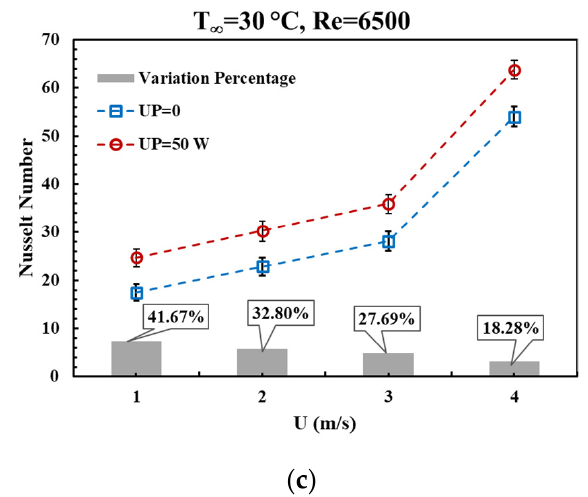
Figure 12. The variations of Nusselt number against U at T ∞ = 30 ( ◦ C ) and Reynolds numbers of ( a ) Re = 2166, ( b ) Re = 4333, and ( c ) Re = 6500. The results are presented in a no-vibration state (UP = 0) and in the presence of vibration with ultrasonic power of 50 Watts (UP = 50 (W)).